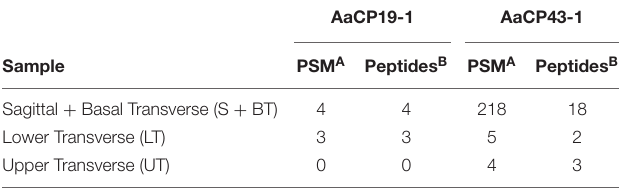
TABLE 1 | Results of proteomic analysis of FFPE